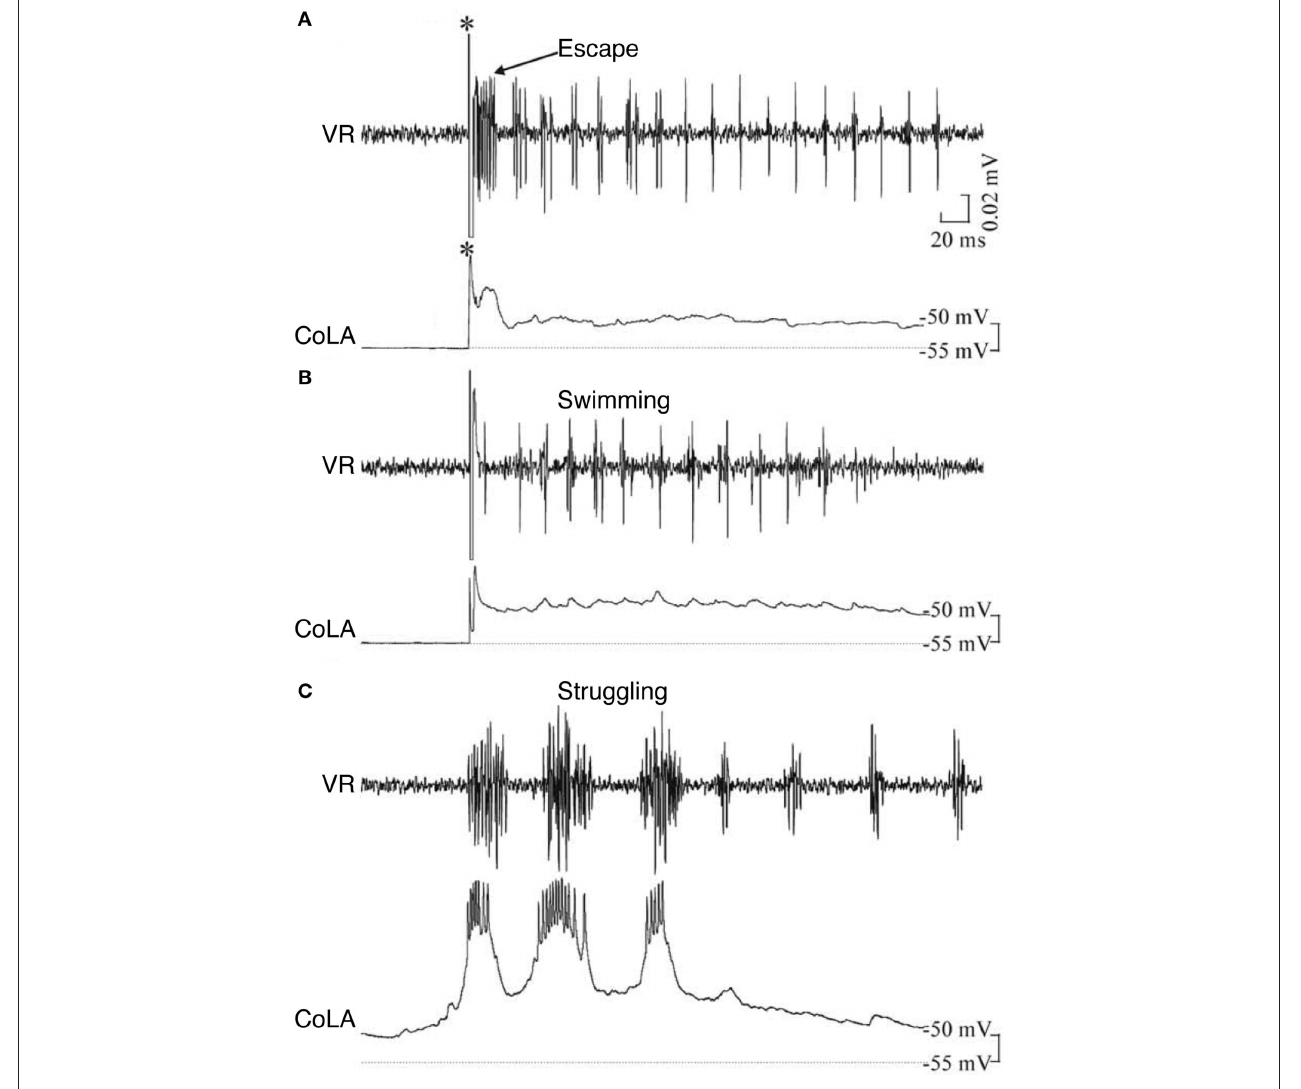
Figure 5 | example of a zebrafish commissural longitudinal ascending interneuron (CoLA), not firing during (A) escape or (B) swimming, but firing strongly during (C) struggling. *, stimulus; VR, ventral root. Adapted from Liao and Fetcho (2008), with permission of the Society for